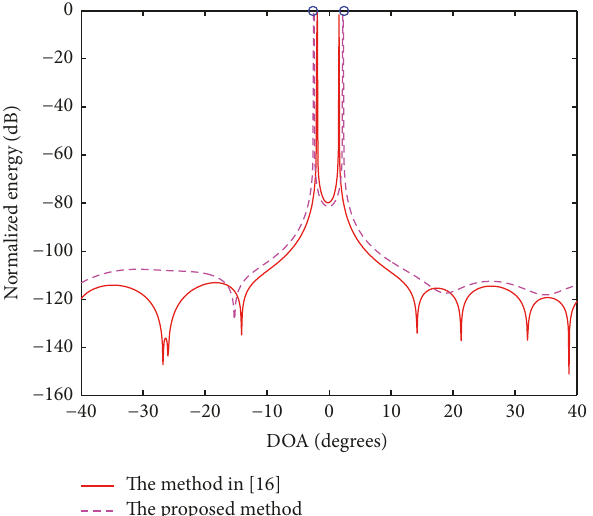
Figure 4: RMSE of DOA estimation versus SNR.